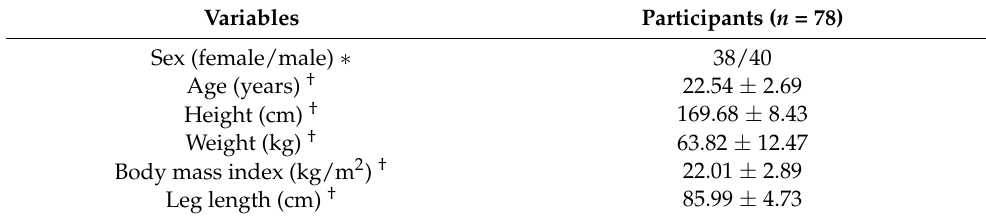
Table 2. General characteristics of participants.